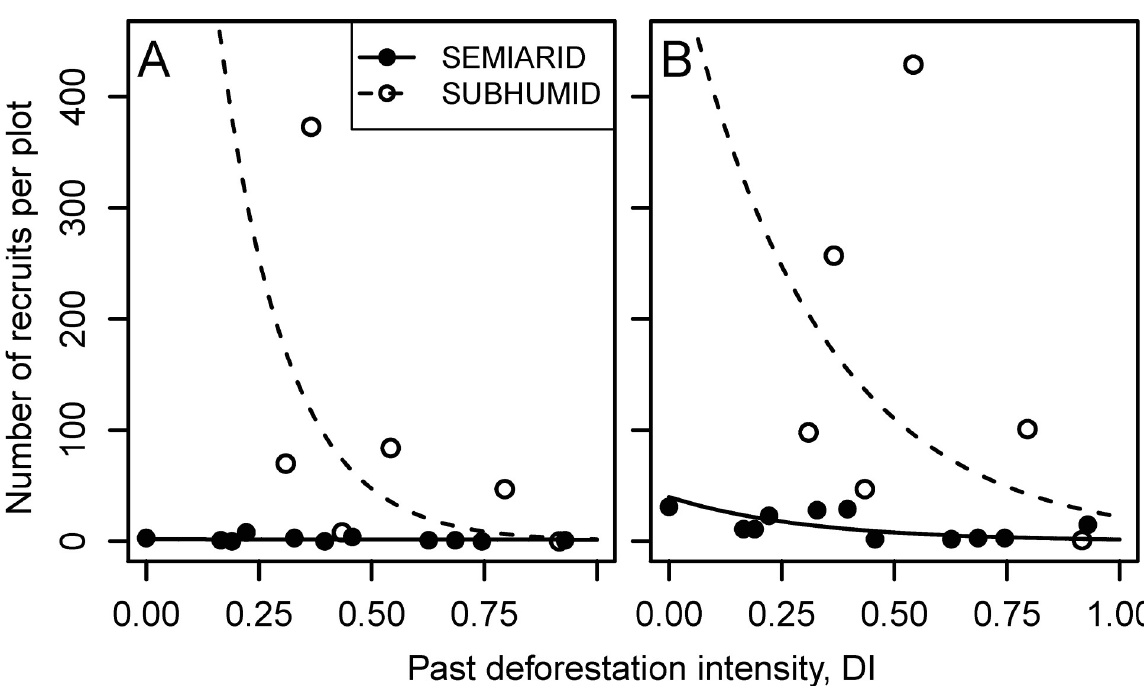
Fig 2. Effect of intensity of past deforestation on the number of recruits of Quercus ilex per plot in each precipitation level. The lines are the estimated models from the Poisson regression, (A) for saplings (recruits 15 years old or younger) and (B) for juveniles (recruits between 16 and 50 years old).